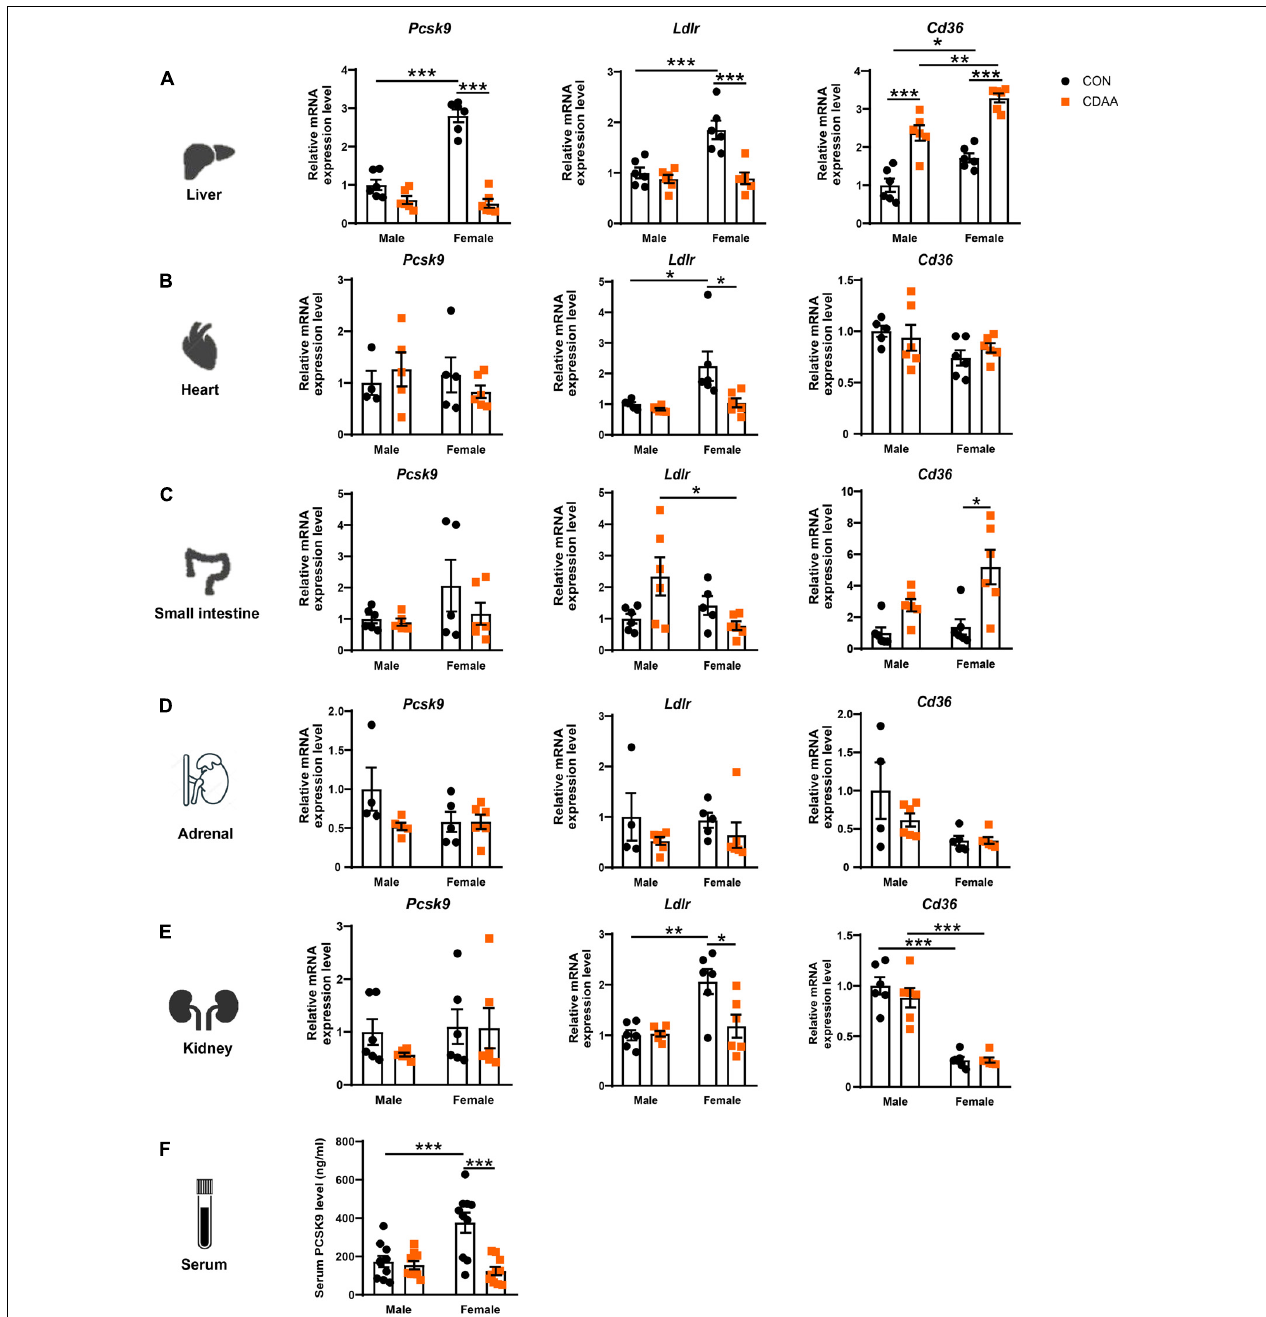
FIGURE 3 | Changes of expression Pcsk9, Ldlr , and Cd36 genes upon CDAA-induced NASH in the liver, heart, small intestine, adrenal, and kidney, as well as PCSK9 serum concentration. Relative gene expression of Pcsk9, Ldlr, and Cd36 from liver (A) , heart (B) , small intestine (C) , adrenal gland (D) , and kidney (E) was measured by qRT-PCR and was normalized to the Rlp13a gene. Serum PCSK9 concentration (F) . Results are shown as mean ± standard error of mean (SEM). * P < 0.05 was considered significant, ** P < 0.01 was considered significant, *** P < 0.001 was considered